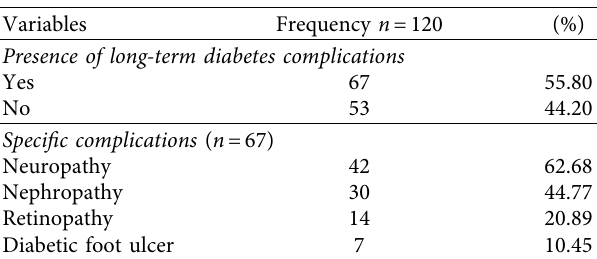
Table 4: Prevalence of long-term diabetic complications among patients with DM admitted to JMC from October 01, 2020, to June 30,